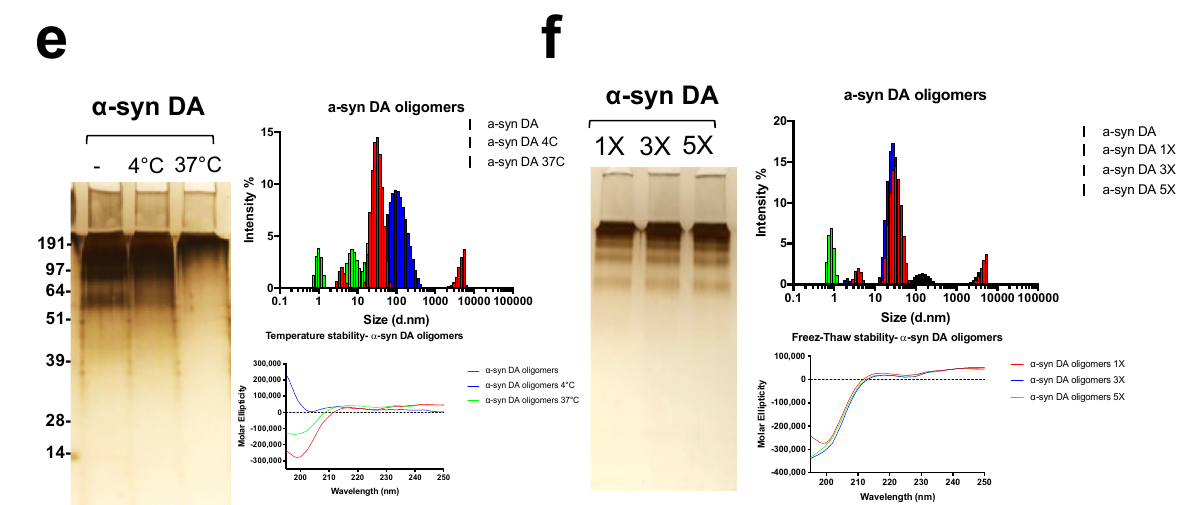
Figure 4. Effect of temperature and freeze–thaw cycles on the stability of oligomers: 5 μM of either α-syn HNE, -ONE, or -DA oligomers were incubated at 4 °C or 37 °C for 5 days ( a , c , e ) or subjected to multiple freeze–thaw cycles ( b , d , f ) and analyzed by silver-staining circular dichroism and dynamic light scattering experiment.